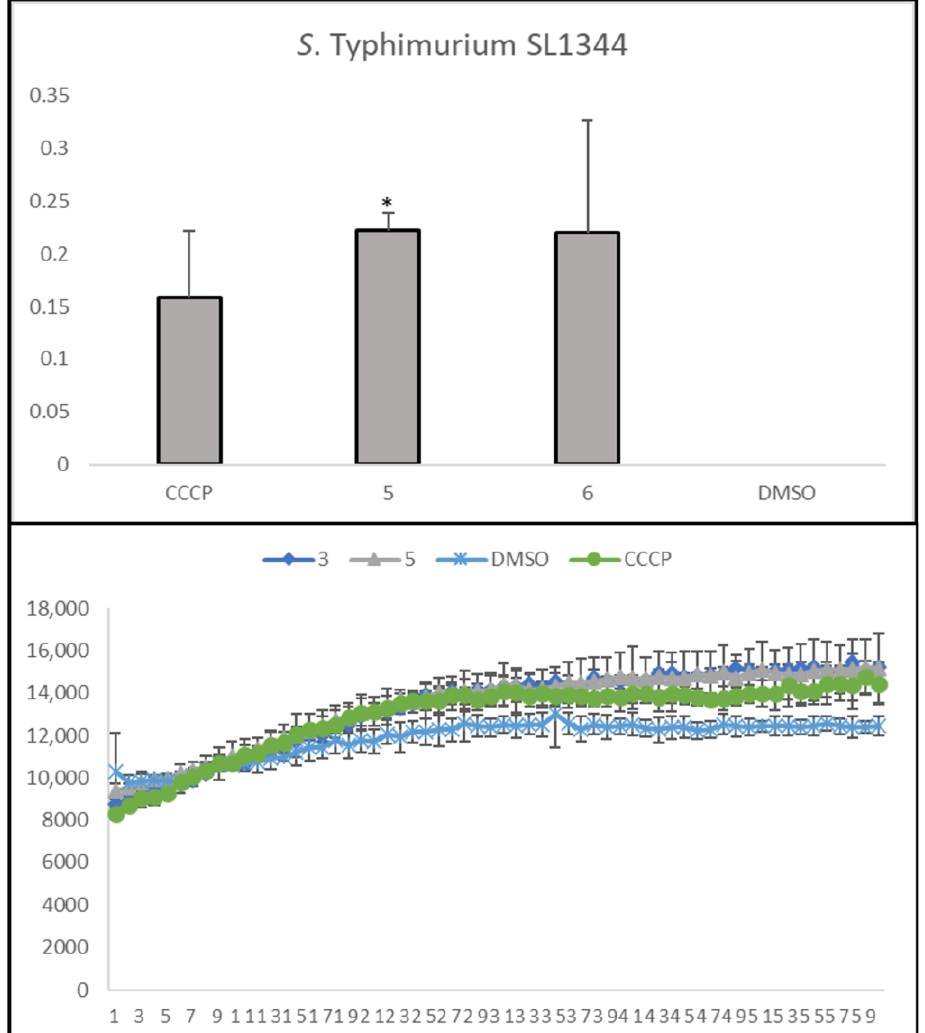
Figure 2. Accumulation of EB in the presence of trimethoxybenzoic acid derivatives 5 and 6 on S. Typhimurium SL1344. DMSO: dimethyl sulfoxide (solvent); CCCP: positive control. Statistical comparisons were performed using the t -test [* p < 0.05 vs. control (DMSO 1 % v/v )].